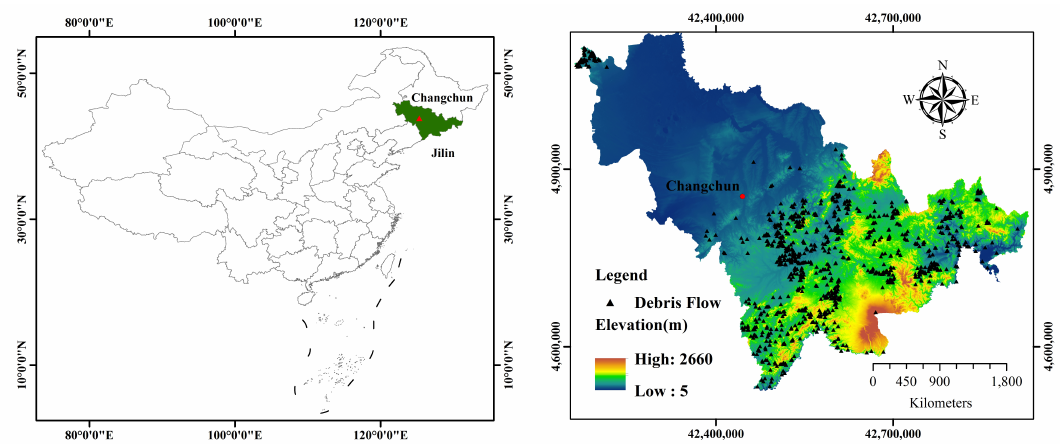
Figure 1. Location of study area and distribution of debris flow.